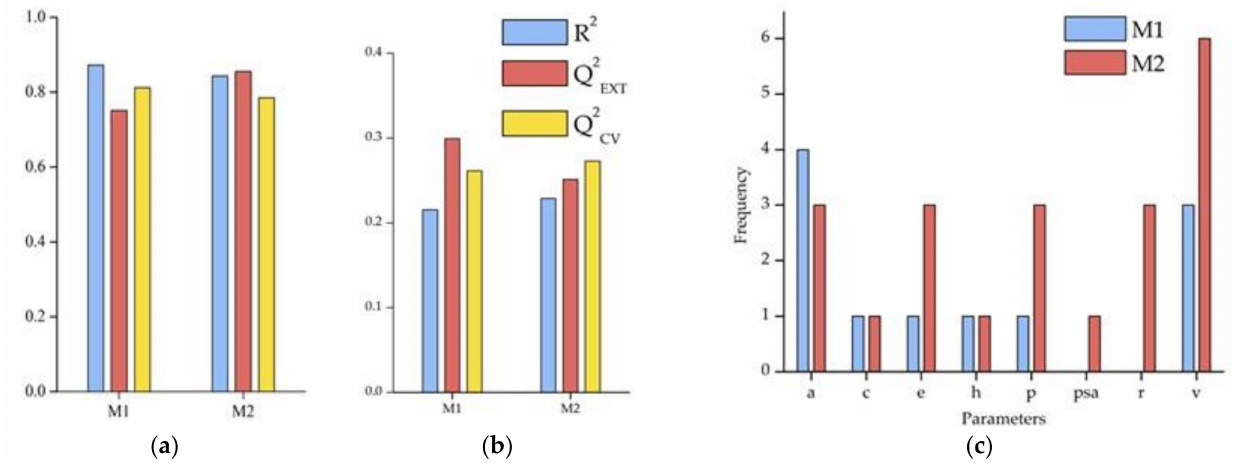
Figure 2. M1 and M2 obtained from SS_1213 and CSE_1393 set of descriptors. ( a ) presents the R 2 , Q 2 CV , and Q 2 EXT values; ( b ) MAE values; and ( c ) is the frequency of the physicochemical properties within the descriptors for M1 and